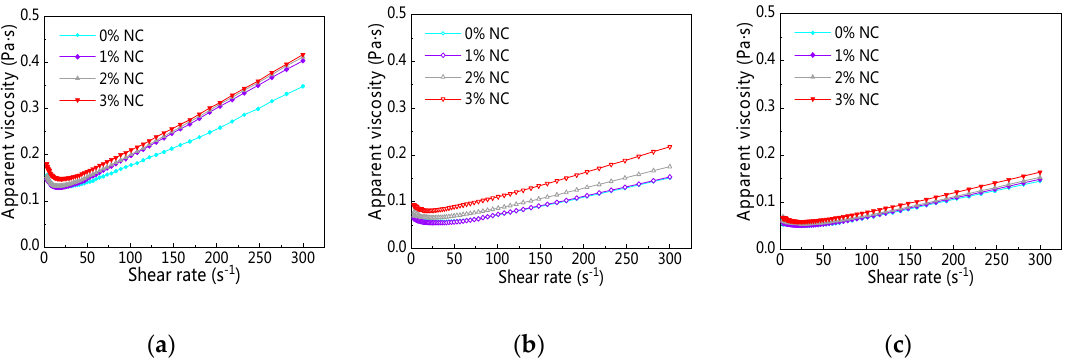
Figure 17. Shear rate vs. apparent viscosity under different NC content: ( a ) 5 min; ( b ) 60 min; ( c ) 120 min.